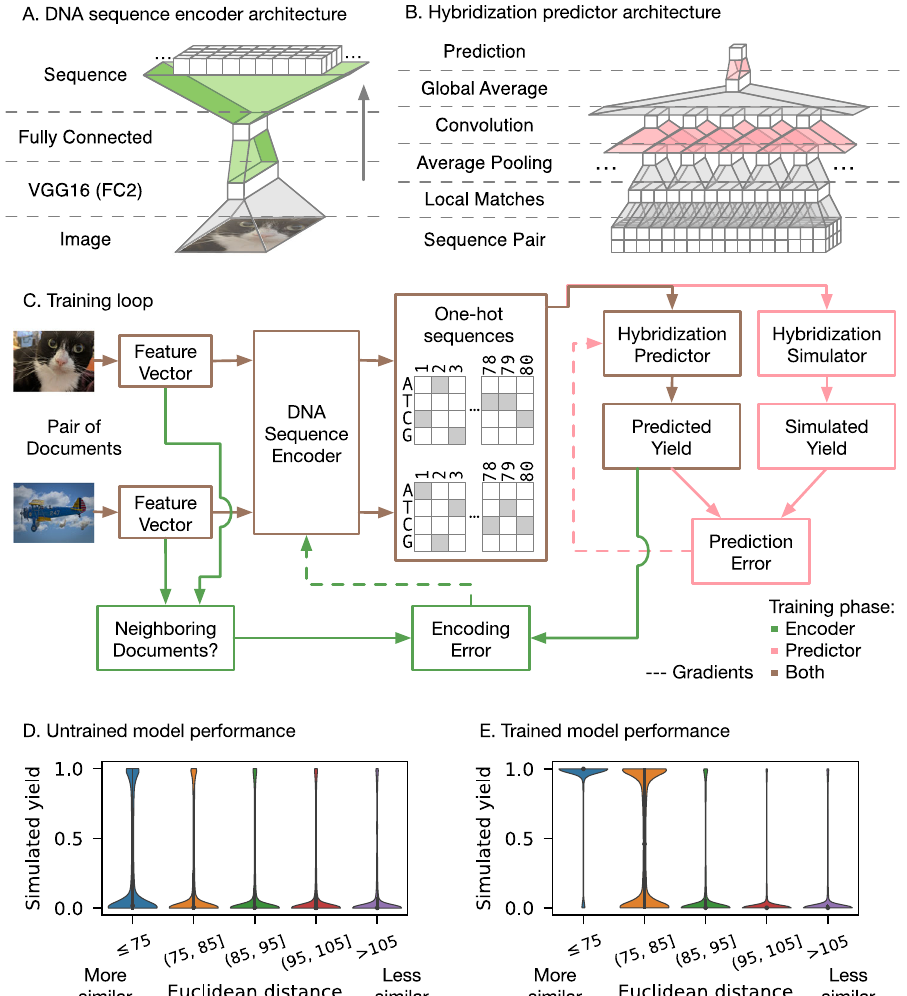
Fig. 2 Overview of our neural network architectures and training process. A, B The neural network architectures for the image-to-sequence encoder, and the hybridization predictor. Boxes represent layers, and trapezoids represent operations to go from one layer to the next. Only the colored operations have parameters that change during training. C The training loop for the neural networks. Lines indicate data fl ow; dashed lines indicate parameter gradients calculated using backpropagation. Green indicates operations only performed during encoder training, while pink indicates operations used only during yield predictor training. All other operations are used in both training phases. D Simulated performance of an untrained model, evaluated on n = 1.6 million random pairs of independent images. Each violin depicts the distribution of simulated hybridizations for pairs whose feature vectors ’ Euclidean distance lie within a certain range. E Simulated performance of a trained model, evaluated on the same set of random pairs (i.e., n = 1.6 million random pairs of independent Figure 2C outlines the training procedure, which alternates between encoder and hybridization predictor training phases. In the encoder training phase, a pair of image feature vectors are compared to determine if they are close enough to be deemed “ similar ” . Supplementary Figure S1 illustrates the relationship between subjective image similarity and feature vector Euclidean distance. Pairs of images with Euclidean distance of 75 or less tend to be consistently similar, so we label these pairs as “ similar ” and all other pairs as “ not similar ” . This distance threshold is a property of the feature space, not of any particular image, so it only needs to be chosen once per type of document being encoded. After determining whether or not they are similar, the pair of image feature vectors are encoded independently to produce a pair of softmax-encoded DNA sequences. These sequences are passed to the hybridization predictor, which computes local matches in a small sliding window that allows for misalignments (Supplementary Fig. S3B), then performs pooling and convolution operations to produce a predicted yield.